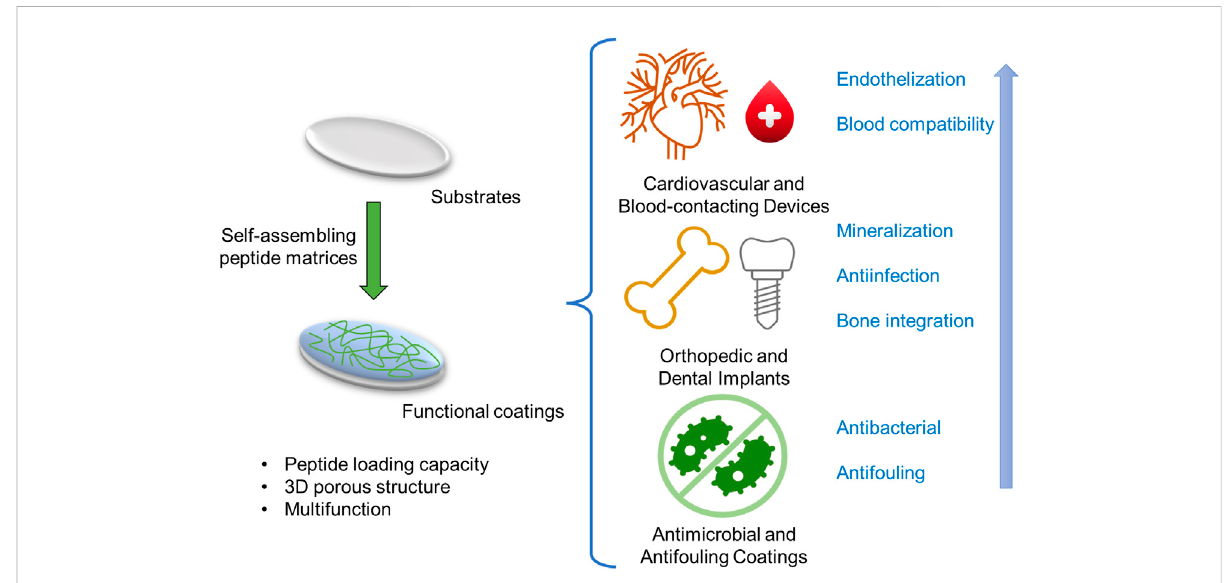
FIGURE 2 The illustration of self-assembling peptide-based functional coatings for implantable